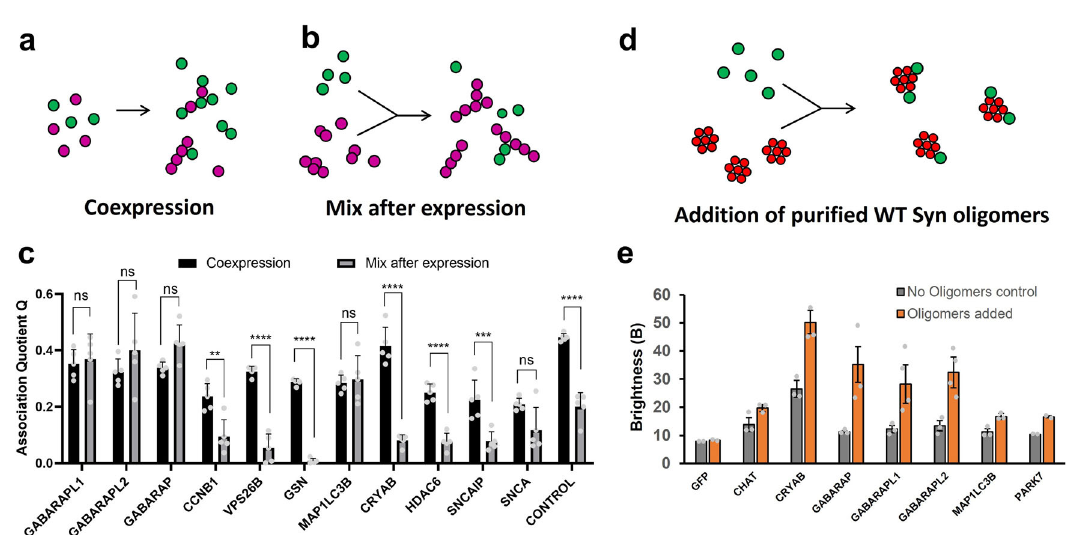
Fig. 4 Mixing after expression levels reveals binders of pre-formed aggregates in LTE cell-free protein expression system. a , b Cartoons depicting co- expressing interactors ( a ) versus mixing interactors with pre-formed aggregates of α -SYN ( b ). Red/Green circles represent mCherry-tagged A53T α -SYN and GFP-tagged Lewy body component, respectively. All experiments were performed with cell-free (co)expression of A53T α -SYN. c Bar plots of Q values with comparison of means using a two-way ANOVA – Dunnett ’ s multiple comparisons test. **** p ≤ 0.0001, *** p ≤ 0.001, ** p ≤ 0.01, * p ≤ 0.05, n ≥ 4. Error bars show mean ± SEM. d Cartoon depicting mixing interactors with puri fi ed oligomers of α -SYN. Red circles represent unlabelled WT α -SYN oligomers and green dots represent GFP-tagged Lewy body components. e Bar plots of brightness values of the GFP-tagged interactors in the presence (orange) or absence (grey) of puri fi ed